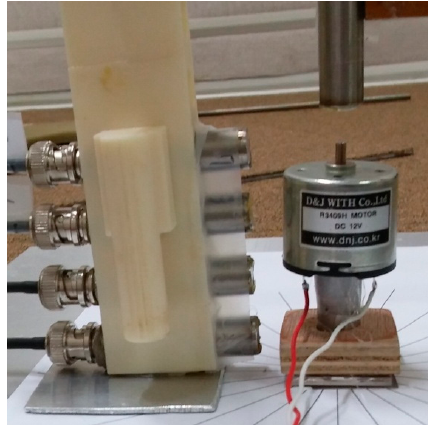
Figure 2. The exterior and interior of small DC motor housing with angular coordinates used for noise measurement: ( a ) exterior of the motor housing, top view; ( b ) interior of the motor housing, bottom view.